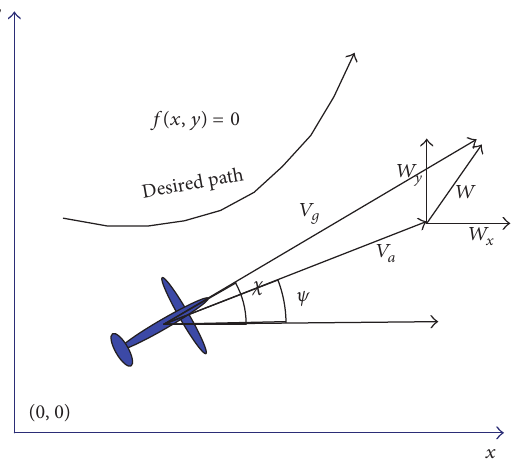
Figure 1: Position of the UAV with respect to the desired path and the relationship among the ground speed, airspeed, and the wind